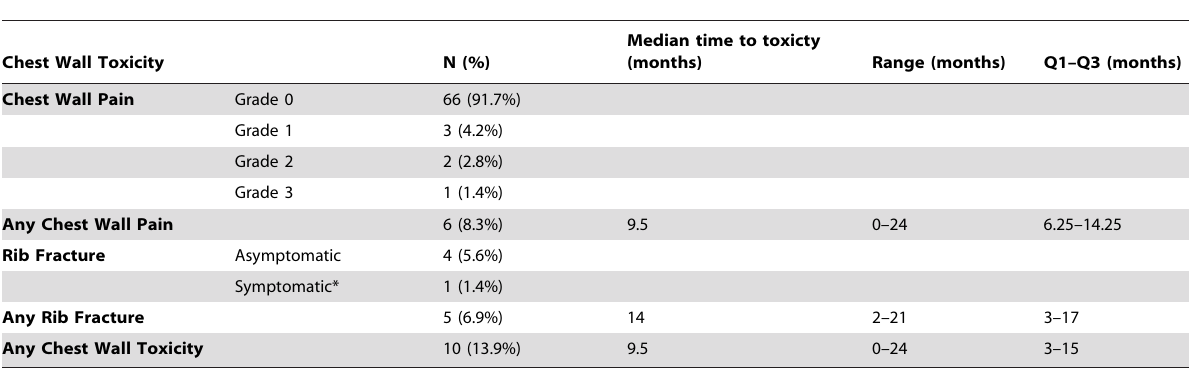
Table 4. Incidence of Chest Wall Toxicities for 72 peripheral lung SBRT treatment plans.